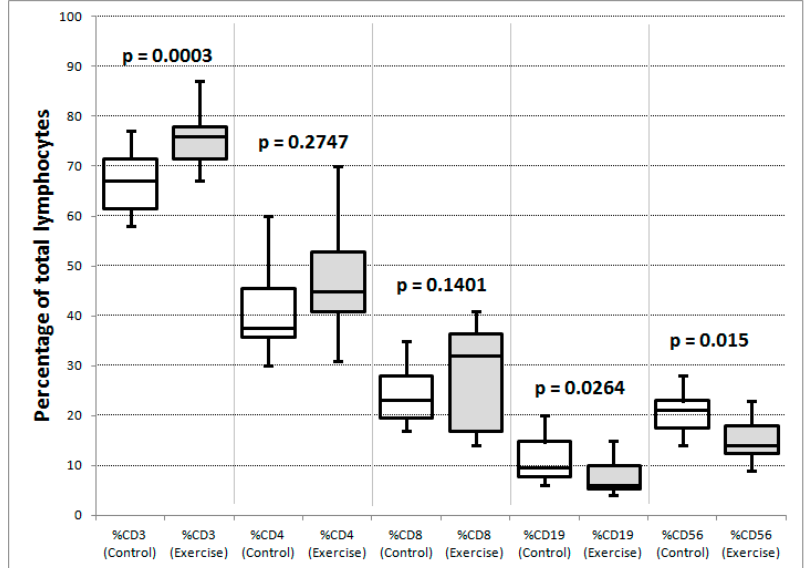
Figure 6. Comparison of lymphocyte subset percentages between control (white box plots) and exercise groups (shaded box plots). Maximum, minimum, quartiles and median are illustrated for each distribution. The p values are for unpaired t -tests (CD3, CD8, NK-cell) and Mann–Whitney tests (CD4, B-cell) depending on whether the data passed or failed a normality test.